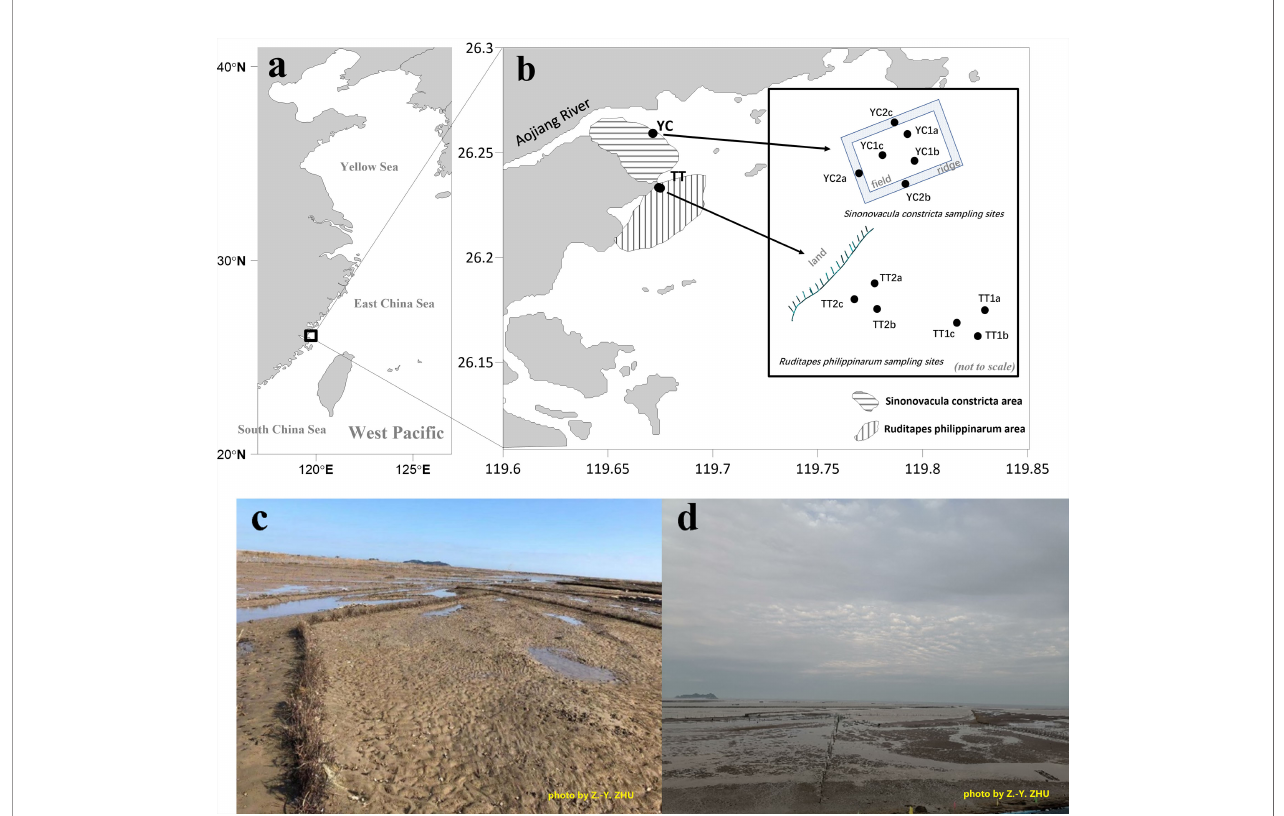
FIGURE 1 | The study area (A) and the location where bivalves (Sinonovacula constricta and Ruditapes philippinarum) are raised (B – D) . The insert in plot b shows the detailed sampling sites. In the text, TT1 and TT2 are referred to as seaward and landward samples of Ruditapes philippinarum sites, respectively, and YC1 and YC2 are referred to as fi eld and ridge samples of Sinonovacula constricta sites. Plot c shows the Sinonovacula constricta sites during low tide and the ridges (about 30 cm in width) between fi elds are manually constructed and regularly maintained with Miscanthus. Plot d shows the Ruditapes philippinarum sites at a time between low tide and high tide. At Ruditapes philippinarum sites there are no ridges. Photo by Z-Y